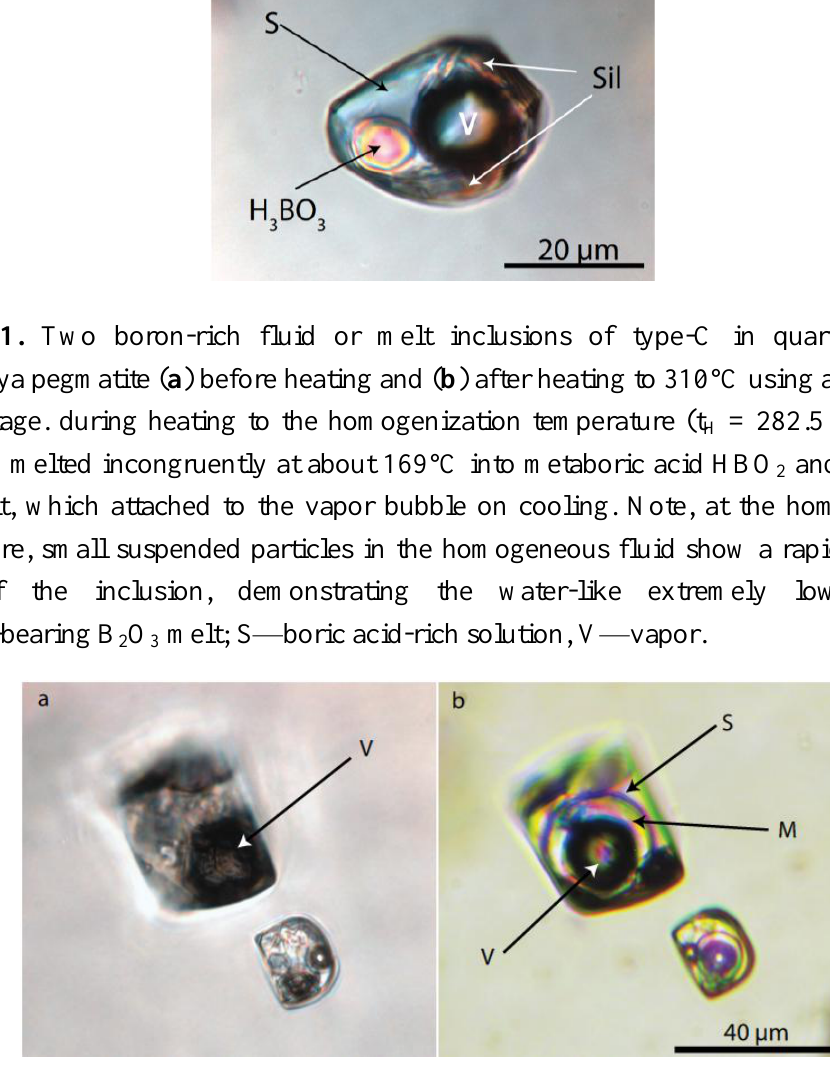
Figure 10. A very water-rich type-B melt inclusion in pegmatite quartz (MX-73-74) containing a sassolite daughter crystal, boric-acid rich solution—S, a vapor phase—V and small amounts of silicate crystals—Sil.